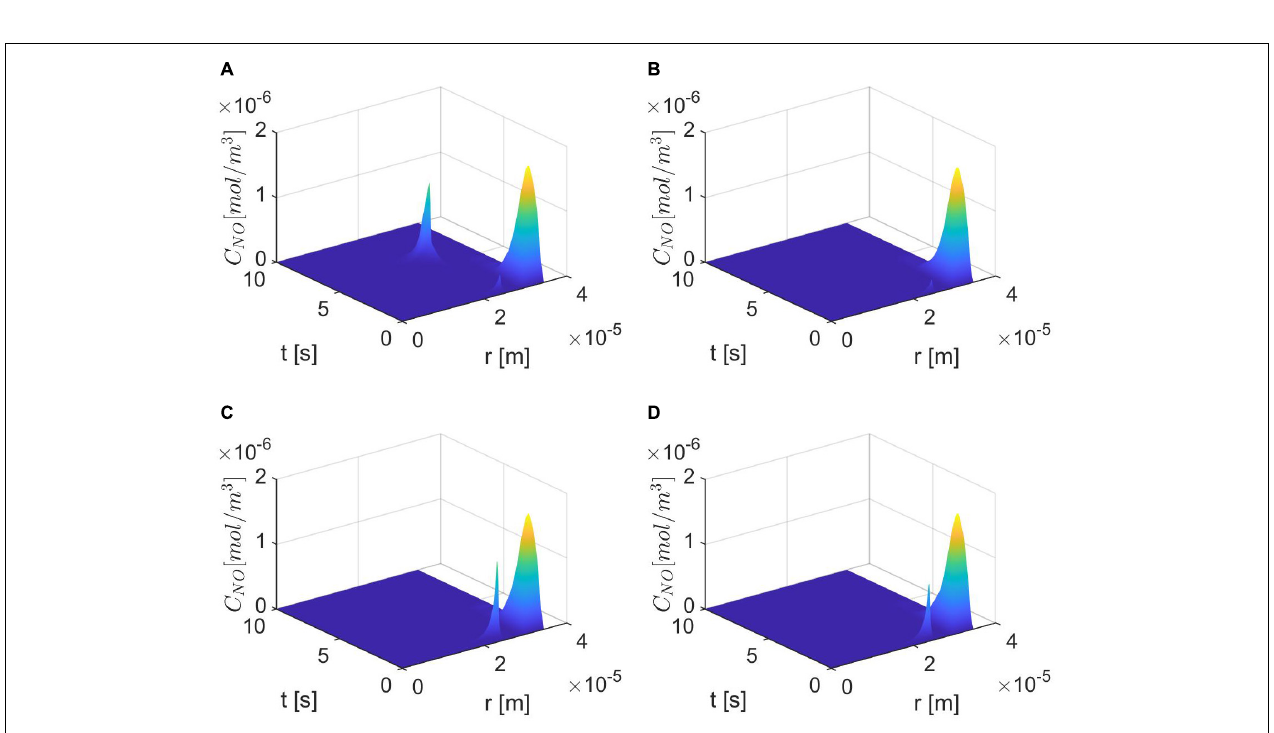
FIGURE 8 | Spatiotemporal variations of C NO for ε = 0 . 85 , p = 0 . 25 ( q = 0 . 75 ), (A) E = 6 × 10 3 N / m , γ = 0 . 75 , ˜ λ = 6 . 5325 × 10 3 s − 1 , (B) E = 6 × 10 4 N / m , γ = 1 . 25 , ˜ λ = 6 . 5325 × 10 3 s − 1 , (C) E = 6 × 10 3 N / m , γ = 0 . 75, ˜ λ = 13 . 065 × 10 3 s − 1 , and (D) E = 6 × 10 4 N / m , γ = 1 . 25, ˜ λ = 13 . 065 × 10 3 s − 1